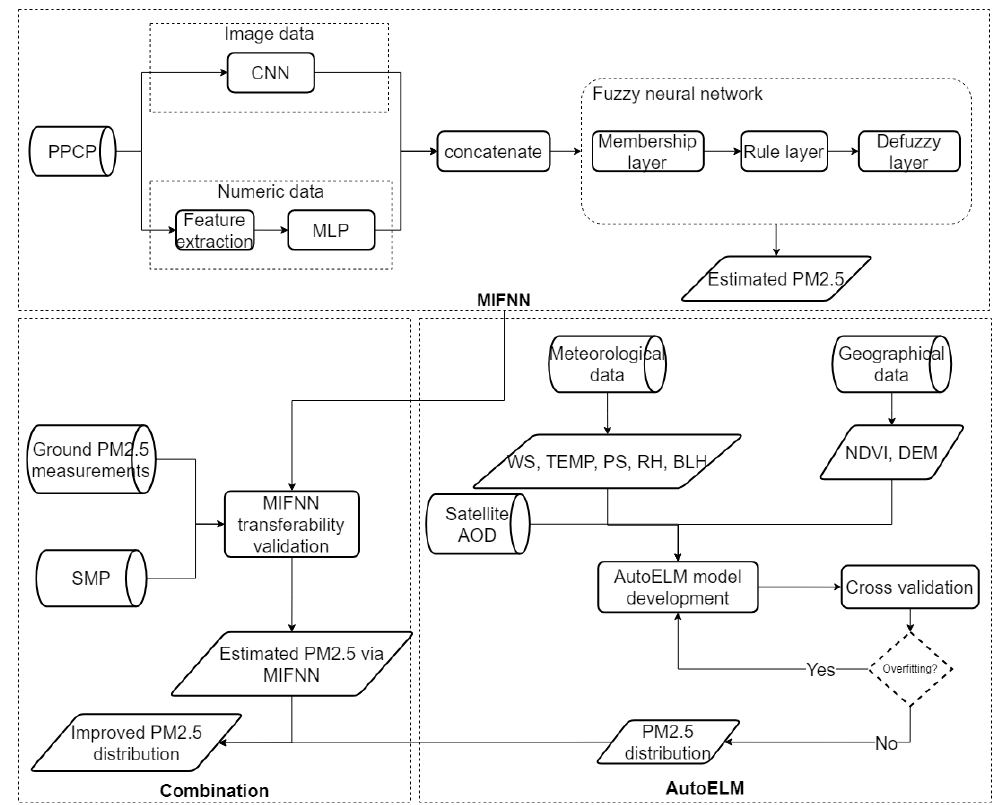
Figure 2. A brief flowchart of our